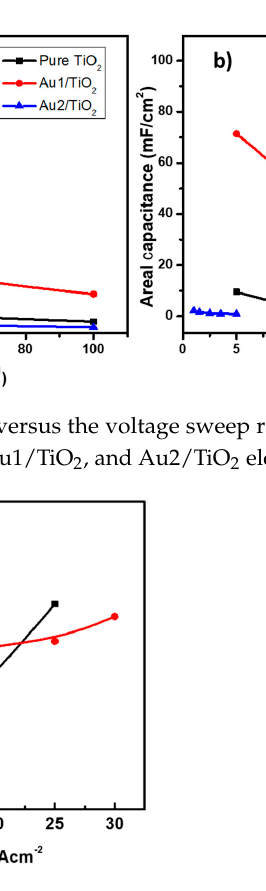
Figure 10. The Coulombic efficiency (CE) calculated from the GCD curves for the three electrodes. The cycling stability of the electrodes is an important parameter to show the readers.